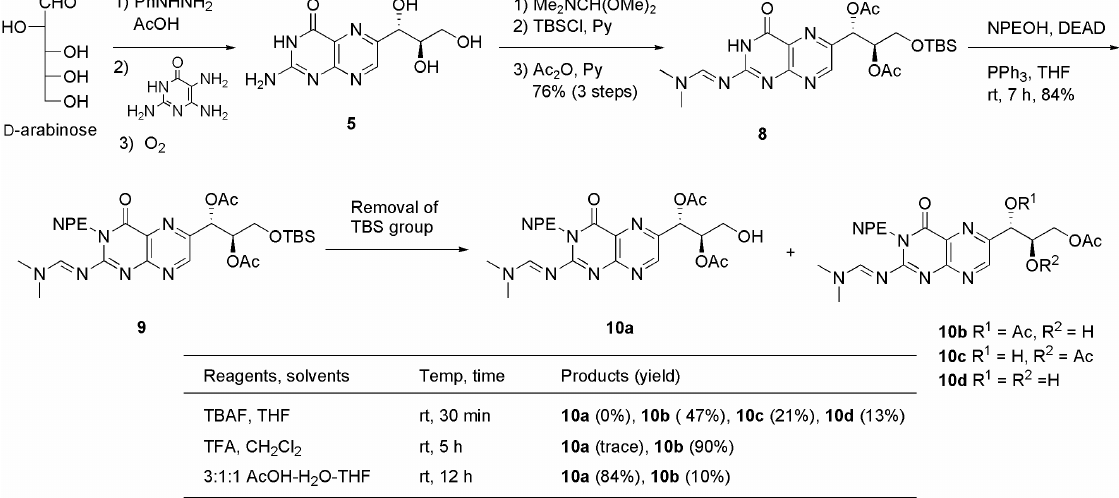
Figure 2: Synthesis of 1',2'-di- O -acetylneopterin derivative